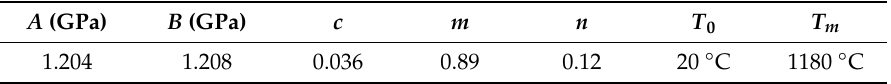
Table 2 . GCr15 Johnson-Cook constitutive model parameter [32,33].